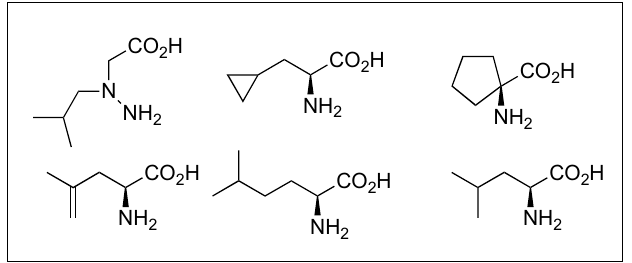
Figure 10. Structures of Leucine derivatives.